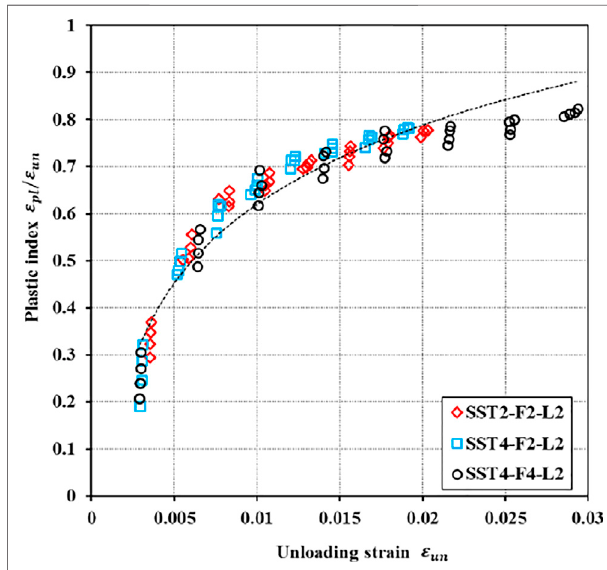
FIGURE 8 | Development of plastic